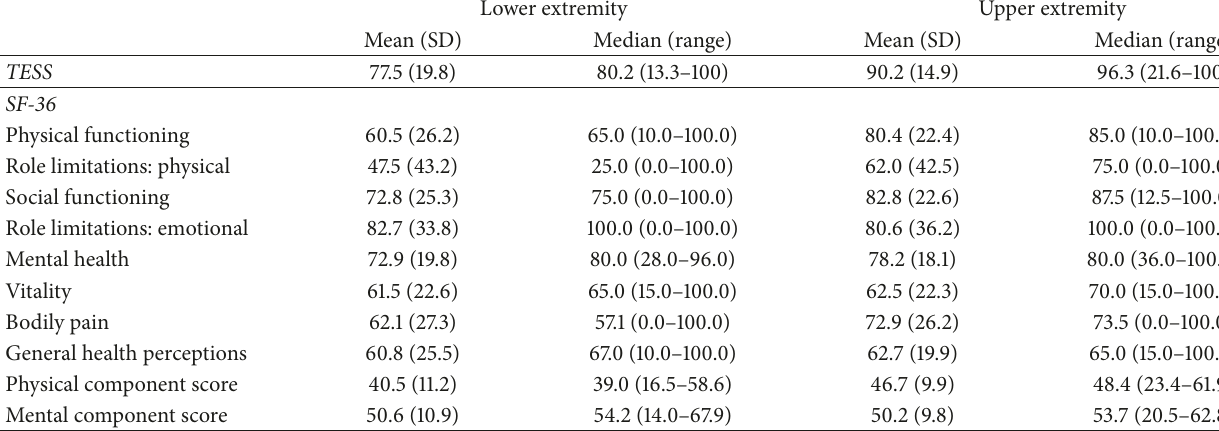
Table 2: Mean and median scores of TESS and SF-36 for the lower and upper extremities.